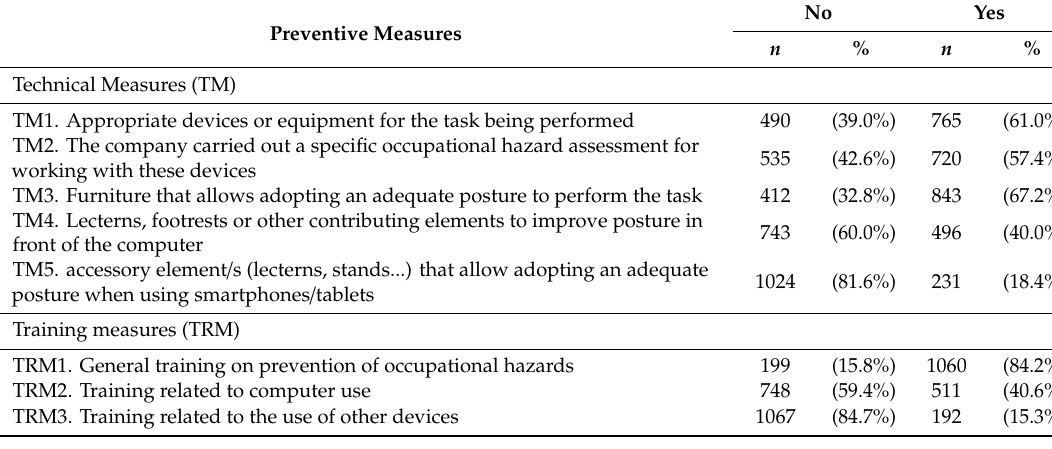
Table 3. Descriptive results (2): absolute and relative frequencies of the preventive measures